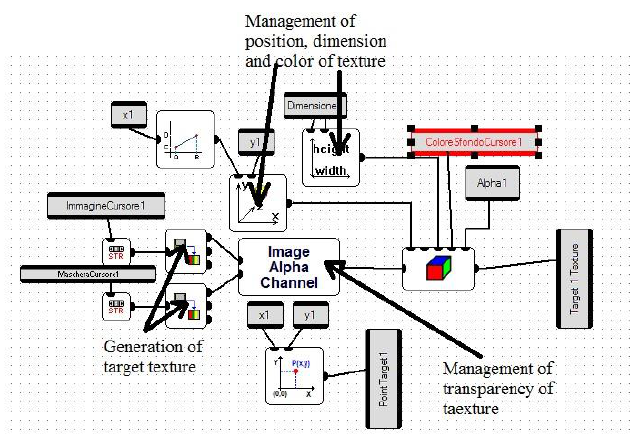
Figure 9. A portion of the CULT EyesWeb patch. It shows the generation of textures and their management.